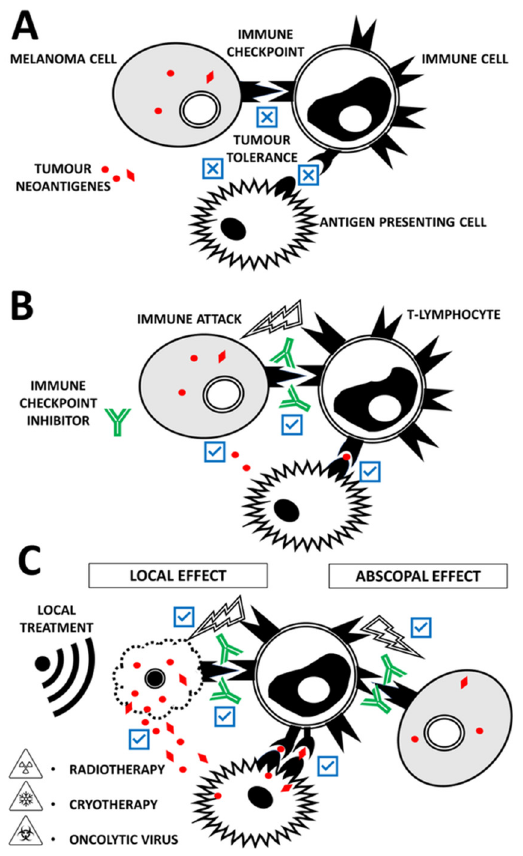
Figure 1. ( A ) Insufficient production and release of neoantigens by the melanoma cells lead to insufficient stimulation of effector immune cells (if present) by antigen-presenting cells. Tumour cells also express negative regulators of T-cell function. The most prominent druggable checkpoint molecules are CTLA-4 and PD-1/PD-L1 (not differentiated); all of them have been associated with immune evasion in cancer. Thus, tumour tolerance can be established. These mechanisms allow cancer cells to avoid destruction by the immune attack. ( B ) Administration of immune checkpoint inhibitors such as anti-CTLA4, anti-PD1 and anti-PD-L1 has remarkable success in enhancing the effector anti-tumour response and triggering the immune attack. However, not all patients respond completely to checkpoint inhibitors. Also, tumour cells can gradually develop mechanisms to avoid immune attack. ( C ) Checkpoint inhibitor therapeutical outcome can be improved in combination with radiotherapy, cryotherapy or oncolytic viruses. All these treatment modalities act locally. Tumour cell damage increases the availability of tumour neoantigens for antigen-presenting cells and effector immune cells. However, immune system activation and thus a therapeutic effect can be observed in the anatomic site, which was not affected by local treatment. This is known as the abscopal effect.